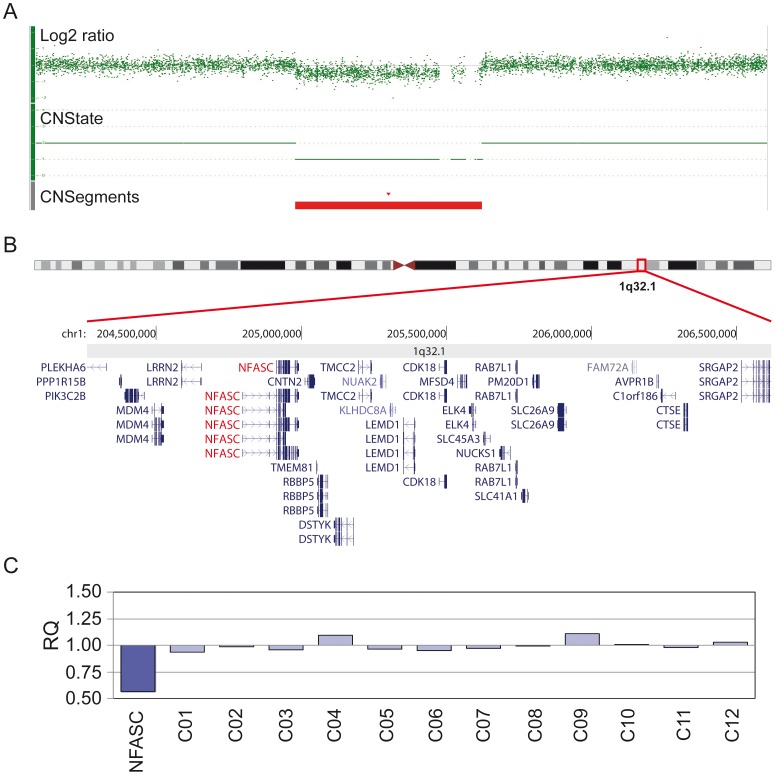
Molecular karyotyping and MLPA confirmation of identified loci.(A) Example representation of the copy number analysis of patient 1 using the Affymetrix Genotyping Console 3.0.2 software. The red bar shows the 2.2 Mb deletion region (CNSegments). (B) Graphical presentation of the deletion region including 33 candidate genes (modified from UCSC genome browser). (C) MLPA confirmation with a probe in the NFASC gene region. A relative quantity value (RQ) below 0.75 was considered as confirmation of a deletion, above 1.25 as confirmation of a duplication. Detailed data for the remaining patients is presented in the supporting information.